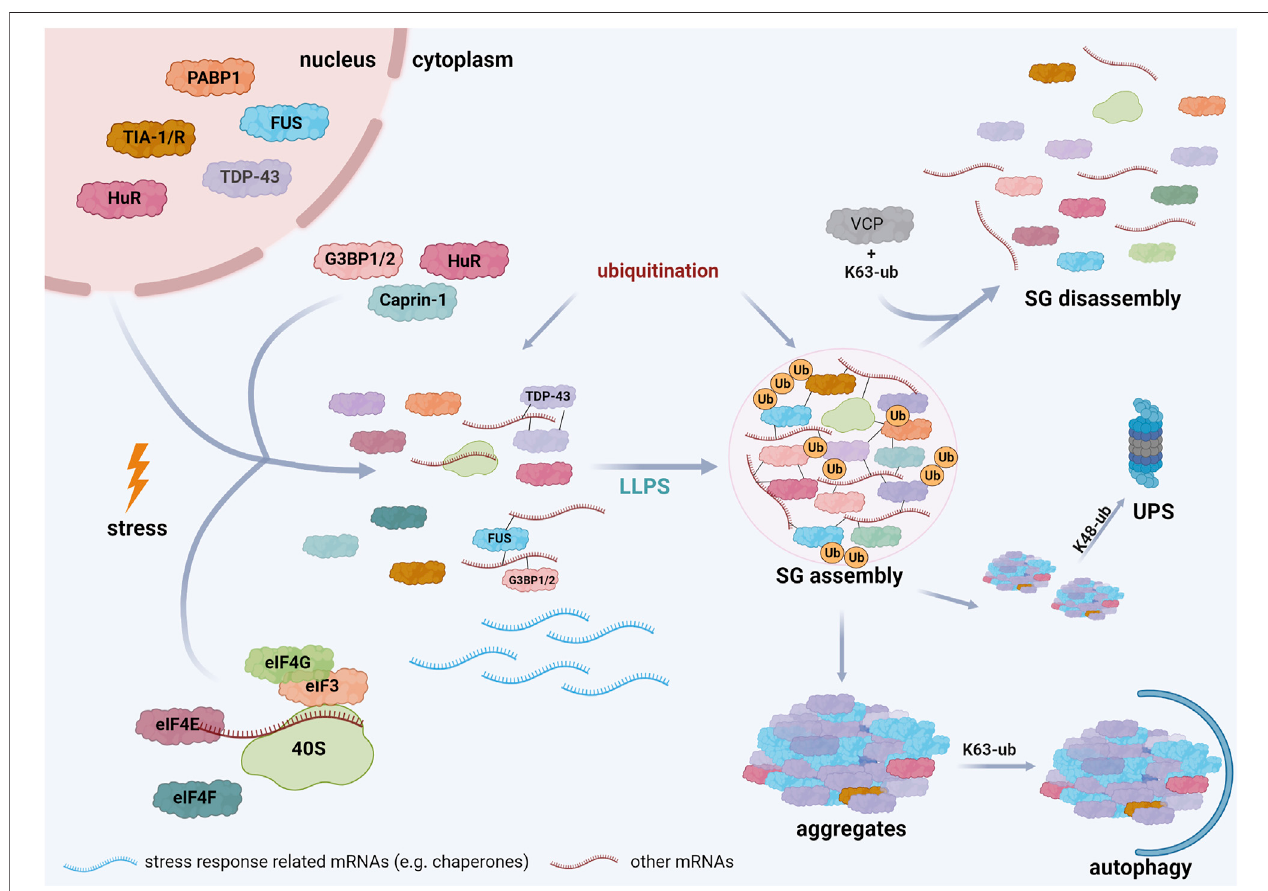
FIGURE2| Schematicrepresentation ofstressgranuleassemblyinthecell. Cellsexposedtoseveralstressconditionsrespondbyinhibiting translation initiationof mRNAsthatarenotimplicatedinstressresponses.ThesemRNAsinteractwithspeci fi cRBPs,suchasTDP-43,FUS,G3BP,andundergoLLPSwhenacriticalthreshold ofinteractionsisreached,resultinginSGformation.BothSGassemblyanddisassemblyareregulatedbyPTMs,includingubiquitination.SGdisassemblyispromotedby K63-linked ubiquitination of G3BP and the interaction of these ubiquitin chains with VCP. Mutations in SG components, prolonged stress, and PTM dysregulation can induce the transition of SGs into pathological aggregates. The elimination of these aggregates is regulated by ubiquitination; K48-linked ubiquitin chains are well established signals for degradation by the ubiquitin-proteasome system (UPS), whereas K63-linked ubiquitination is rather implicated in autophagosomal degradation. Created with BioRender.com.